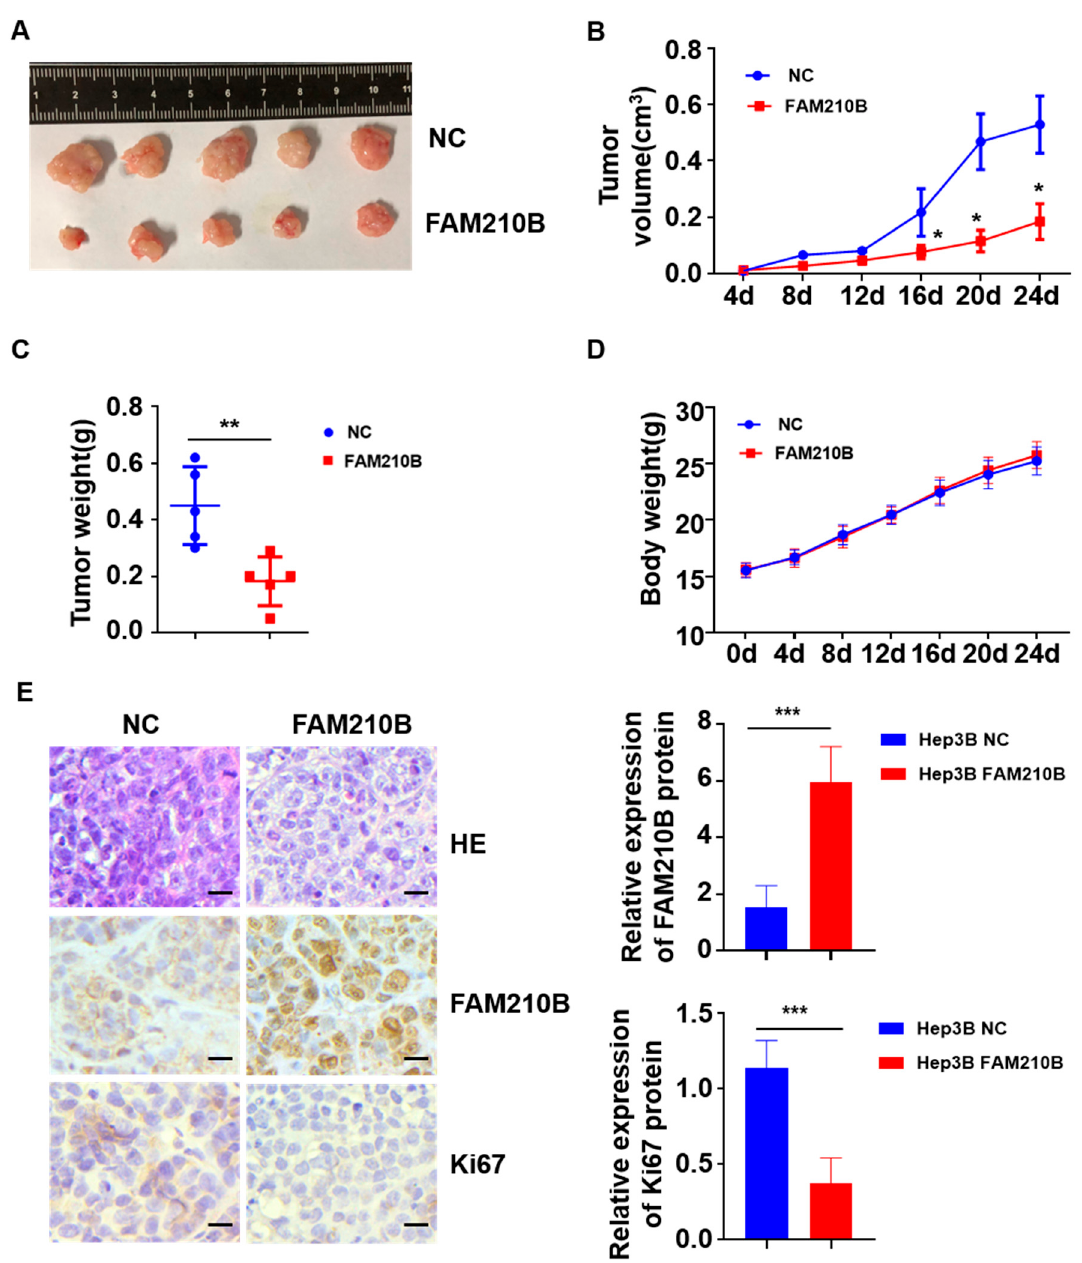
Figure 4. FAM210B overexpression inhibited tumor growth in vivo. ( A ) Xenograft tumor formation assay was performed with inoculated cell numbers of 3 × 10 6 cells per site (n = 5/group). Images demonstrated typical tumor formation the following subcutaneous injection of FAM210B overexpressed Hep3B cells into nude mice. ( B ) The tumor volume was periodically tested for each mouse and the tumor growth curve was plotted. ( C ) The tumor mass was measured. ( D ) The body weights of mice were shown as a curve for the two groups. ( E ) FAM210B and Ki67 expression levels were detected by immunohistochemistry (Scale bar = 200 µm). *: p < 0.05; **, p < 0.01; ***, p < 0.001.